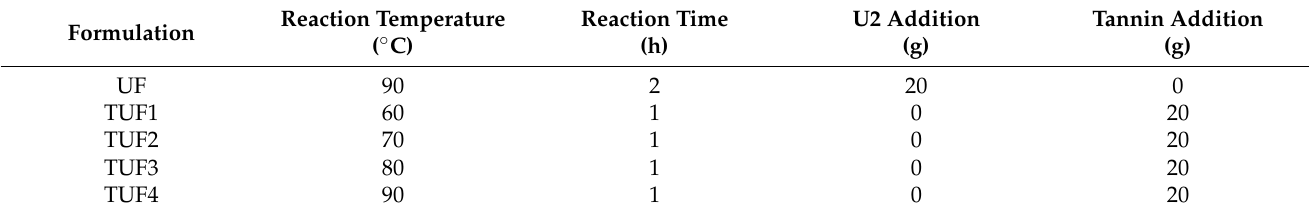
Table 1. Reaction temperature as a variable for the synthesis of UF/TUF resins.